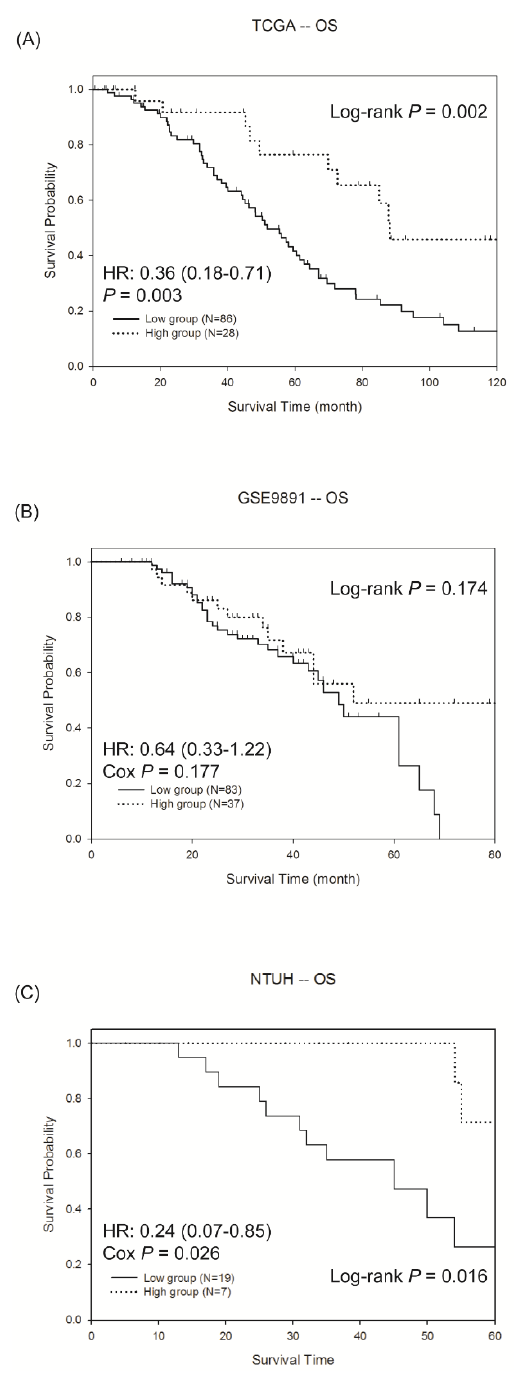
Figure 3. The Kaplan-Meier survival curves of the overall survival (OS) in the high and low response groups in the ( A ) TCGA dataset, ( B ) GSE9891 dataset and ( C ) NTUH patients. Patients of high response group had longer OS than low response group in the three cohorts. The hazard ratio (HR) was estimated by the Cox hazard regression model.